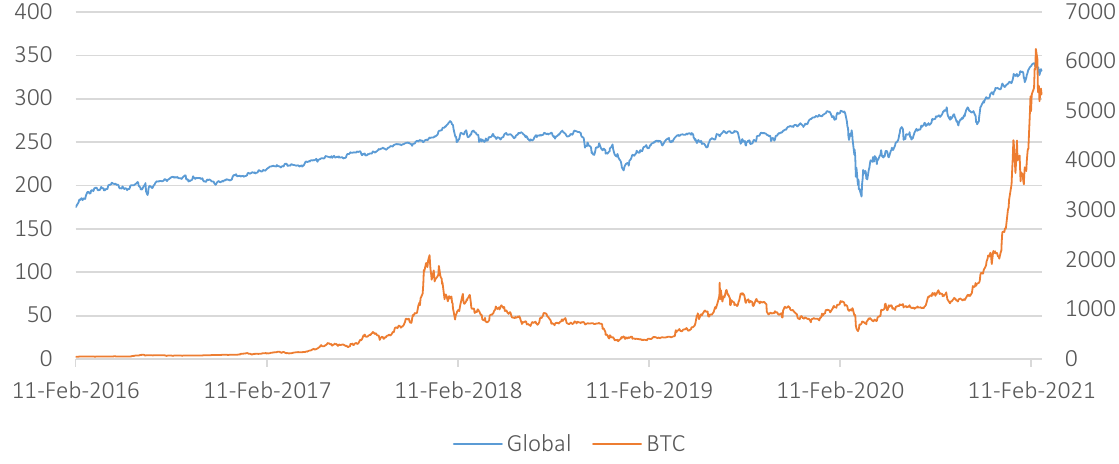
Figure 2. Bitcoin (BTC) and the S&P Global Broad Market Index